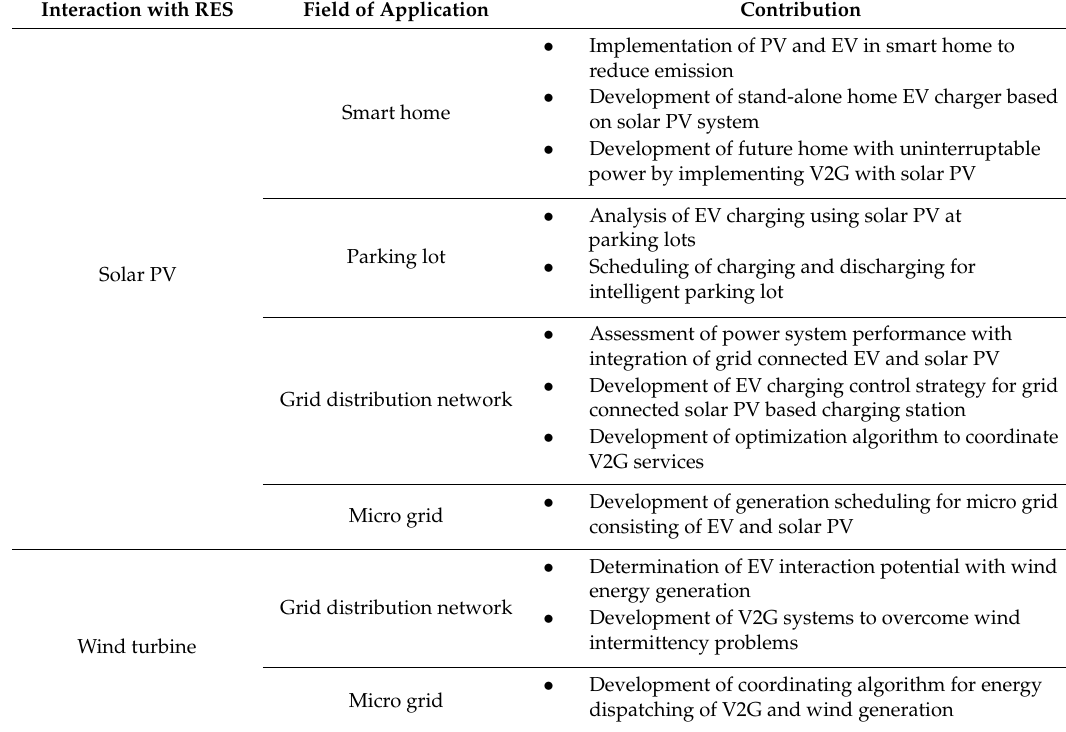
Figure 63. Wind and solar integration in the grid with the help of EV in V2G system. TSO stands for transmission system organization; DSO for distribution system organization; T1 to T4 represent the transformers coupling the generation, transmission, and distribution stages [117]. Table 27. Scopes of assisting renewable energy source (RES) integration using EV. Adapted from [1]. Interaction with